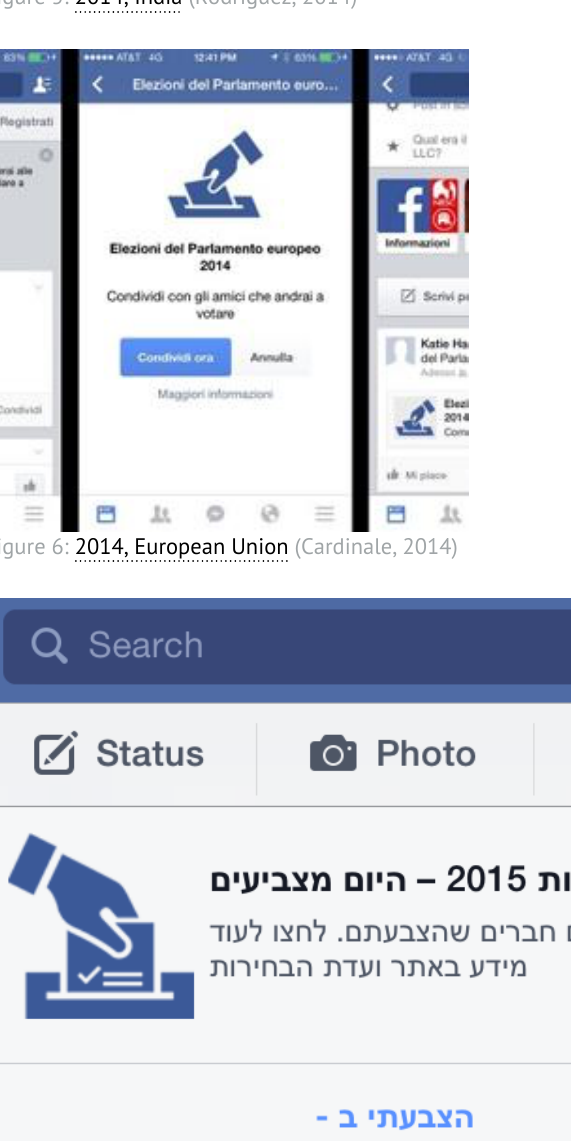
Figure 5: 2014, India (Rodriguez, 2014)